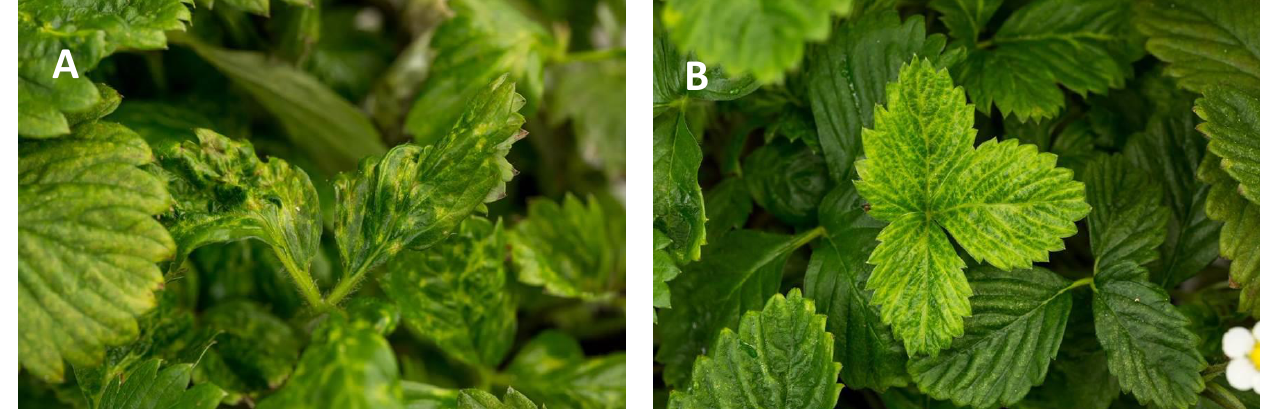
Figure 1. Virus-like symptoms on select strawberry plants that were sampled during the study. ( A ), plant infected by beet pseudo yellows virus and strawberry crinkle virus; ( B ), plant infected by strawberry vein banding virus.